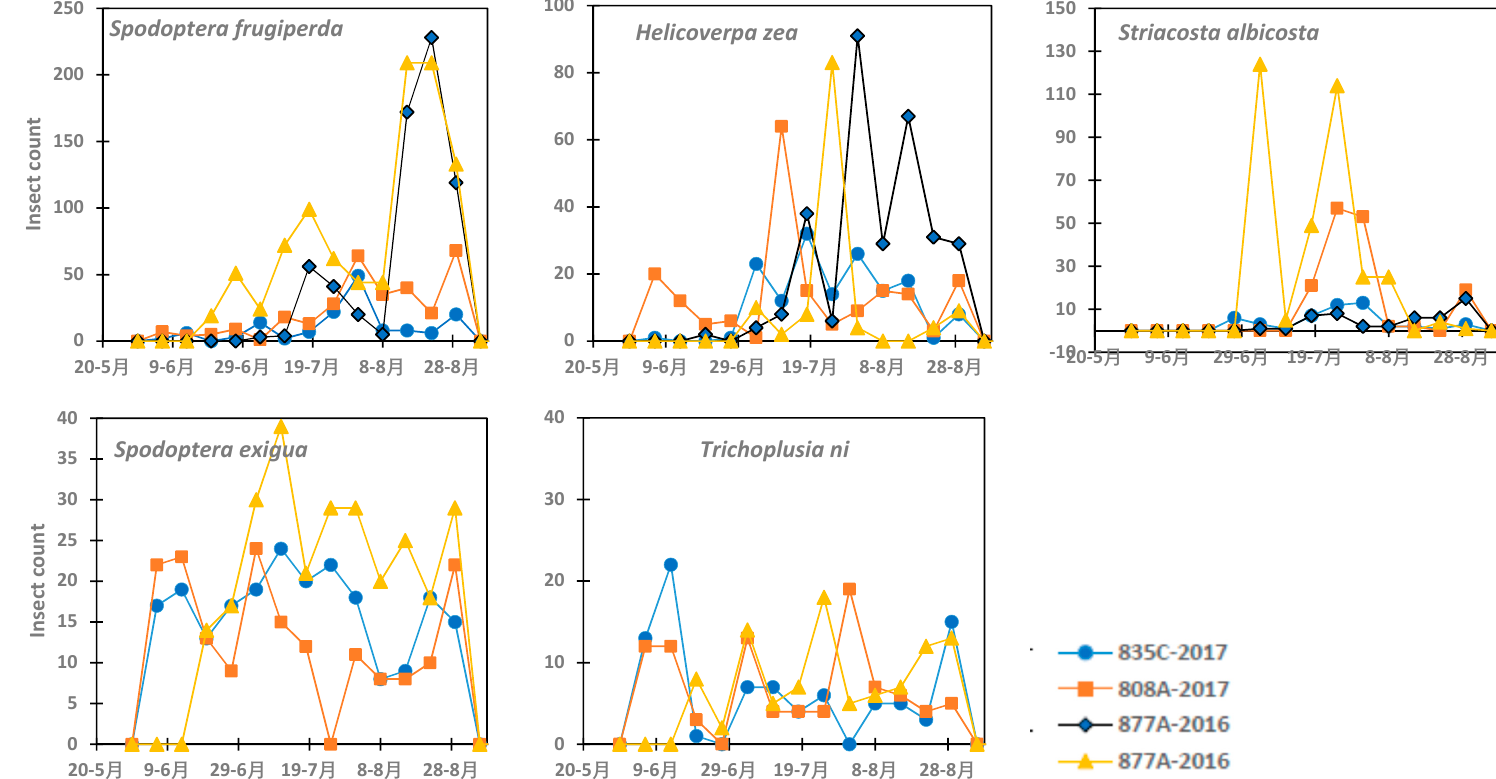
Figure 4. Variation in the population density of five insect pests at the Navajo Agricultural Products Industry farm ( Bactericera cockerelli was not present).